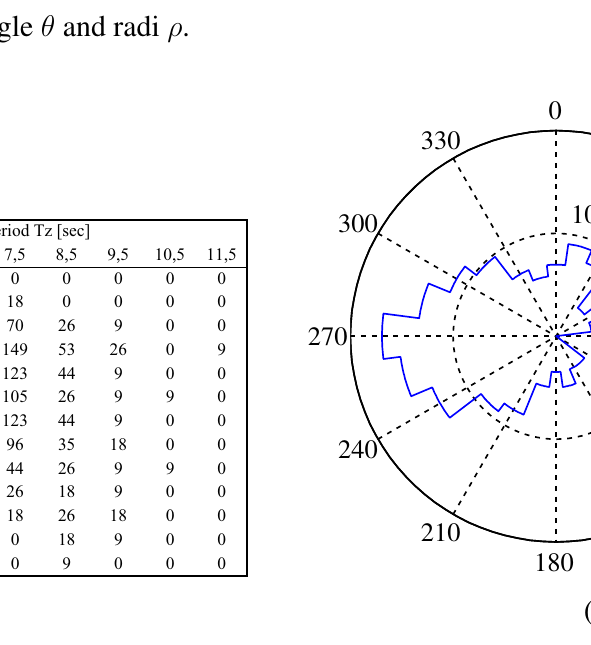
Figure 10. Wave climate at Wavehub. ( a ) Wavehub scatter diagram. Hours per wave state; ( b ) Probability distribution of wave direction on Wavehub. The plot is a logarithmic polar plot defined by the angle θ and radi ρ